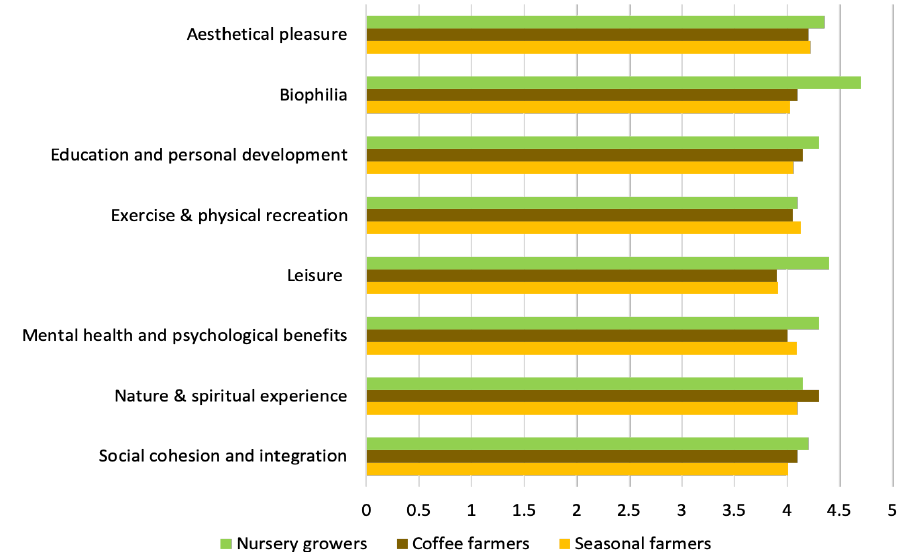
Figure 5. Farmer perception about the importance of cultural ecosystem services derived from urban farms.